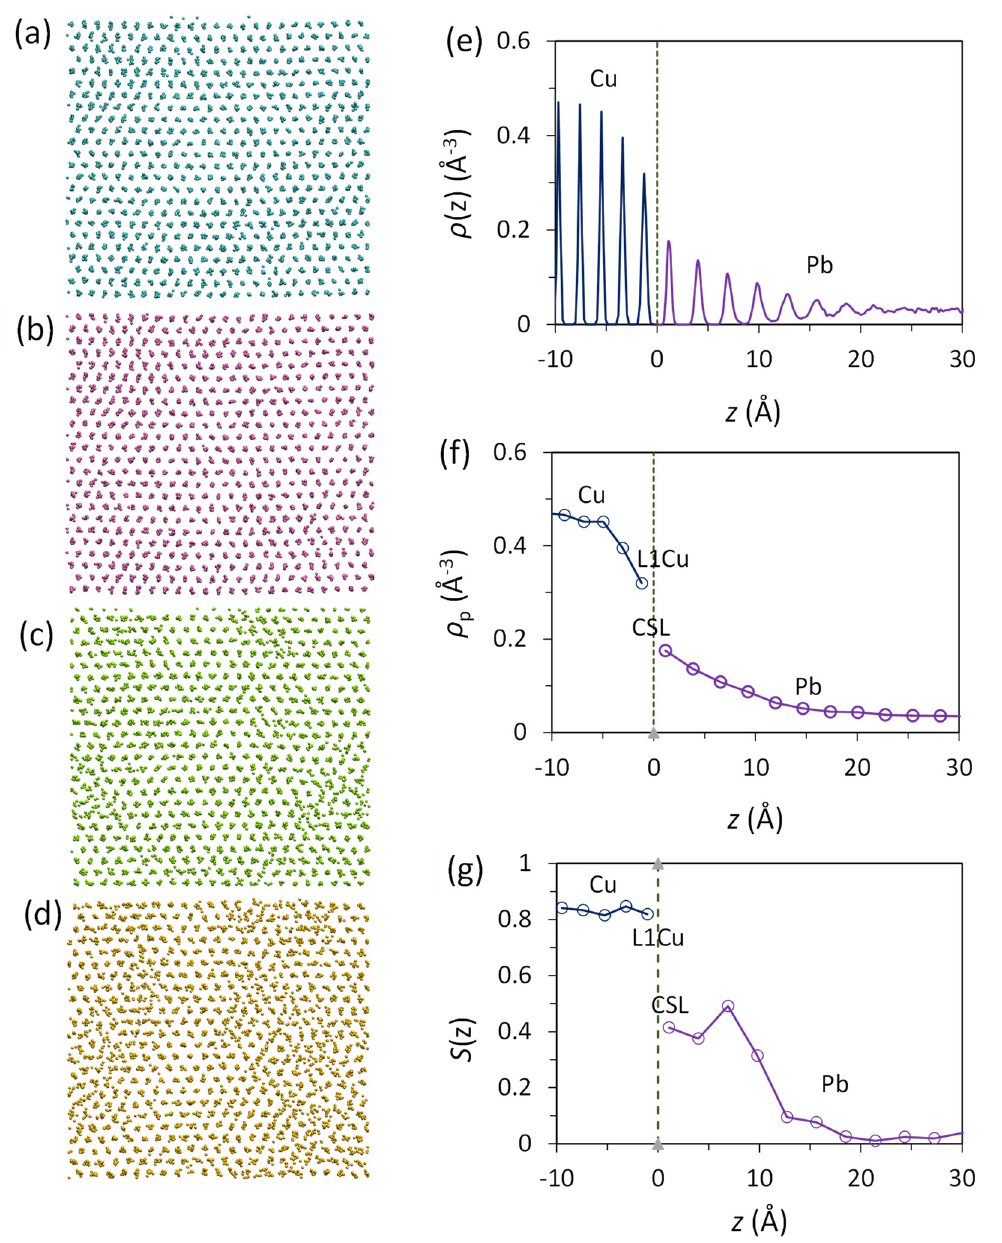
Figure 6. Nucleation precursor represents the maximum atomic ordering in the liquid adjacent to the interface prior to the onset of nucleation. Time-averaged atomic positions of ( a ) CSL, ( b ) L1Pb, ( c ) L2Pb and ( d ) L3Pb. ( e ) Density profile, ρ ( z ); ( f ) peak density, ρ p ( z ); and ( g ) in-plane atomic or- dering, S ( z ), are plotted as a function of distance z from the interface for the Pb( l )/Cu( s ) system at t = 0 ps during the simulation at T n = 594 K.